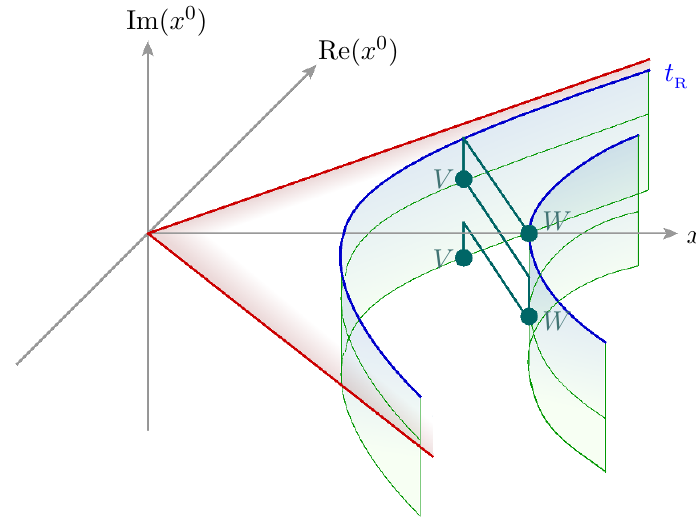
Figure 1 . Out-of-time-order con(cid:12)guration in Rindler space. Inside the red shaded Rindler wedge we show two Rindler time trajectories in blue, which are at constant geodesic separation. The four operators are inserted at the green dots. We show the out-of-time-ordered con(cid:12)guration by including a small amount of imaginary